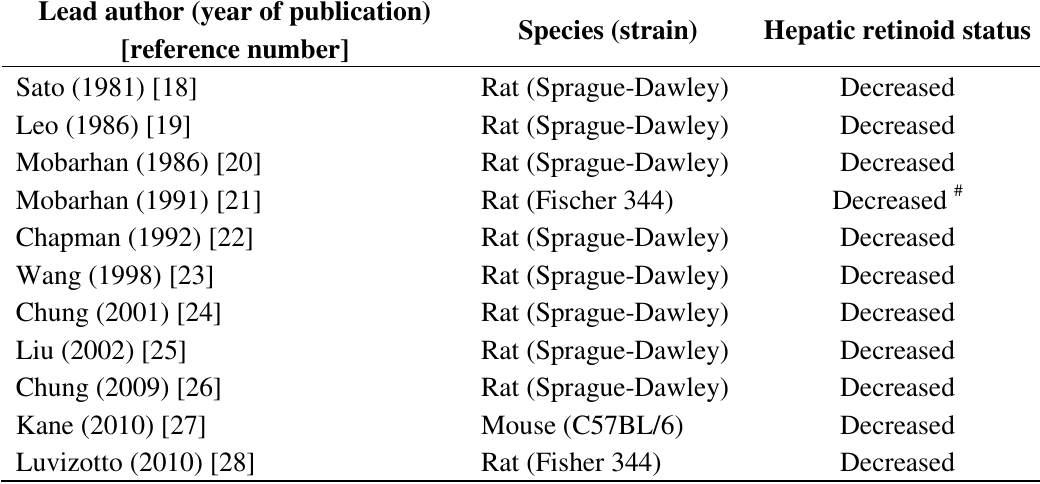
Table 1. Summary of rodent studies exploring the effect of chronic alcohol consumption on hepatic retinoid